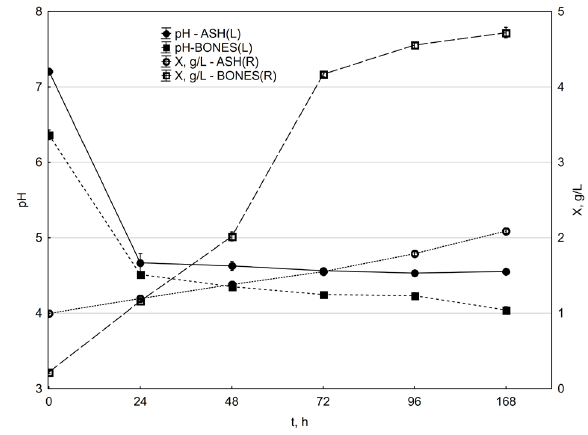
Figure 2: The kinetics of changes in pH and the biomass concentration during the solubilization process.